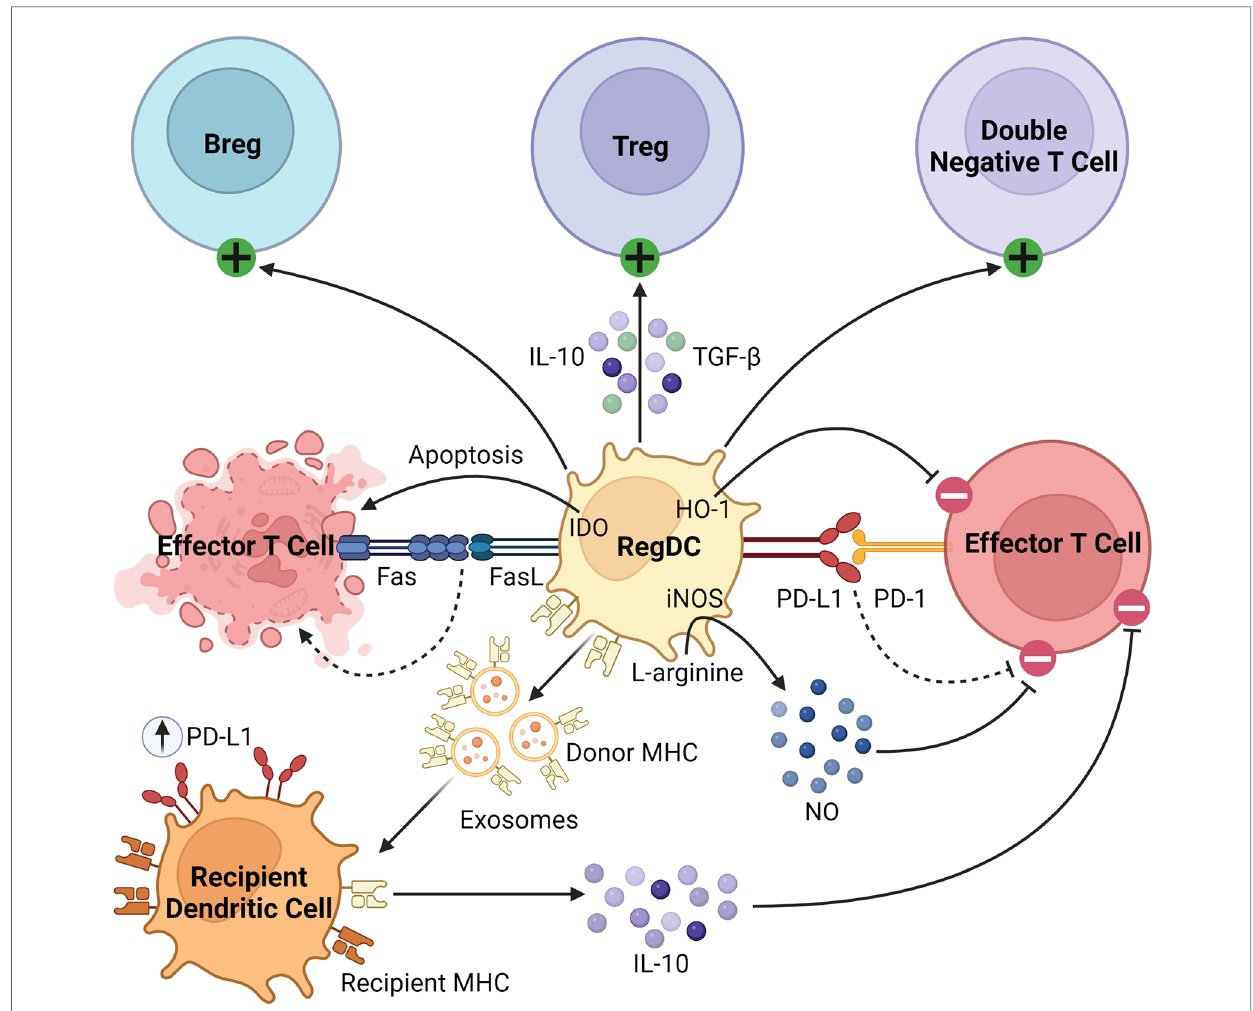
FIGURE 2 Immunosuppressive mechanisms of regDCs. RegDCs express PD-L1 and FasL to inhibit or delete effector and memory T cells through direct cell-cell contact. They also inhibit effector T cell activation through HO-1 and IDO signaling. They activate and promote the differentiation of Bregs, Tregs, and double negative T cells, and secrete anti-in fl ammatory cytokines including TGF β , NO, and IL-10. Finally, donor regDCs release exosomes carrying donor MHC, creating “ cross-dressed ” recipient DCs via trogocytosis. These recipient DCs then upregulate inhibitory cell surface receptors (such as PD-L1) and secrete anti-in fl ammatory cytokines (such as IL-10) to further inhibit alloreactive T